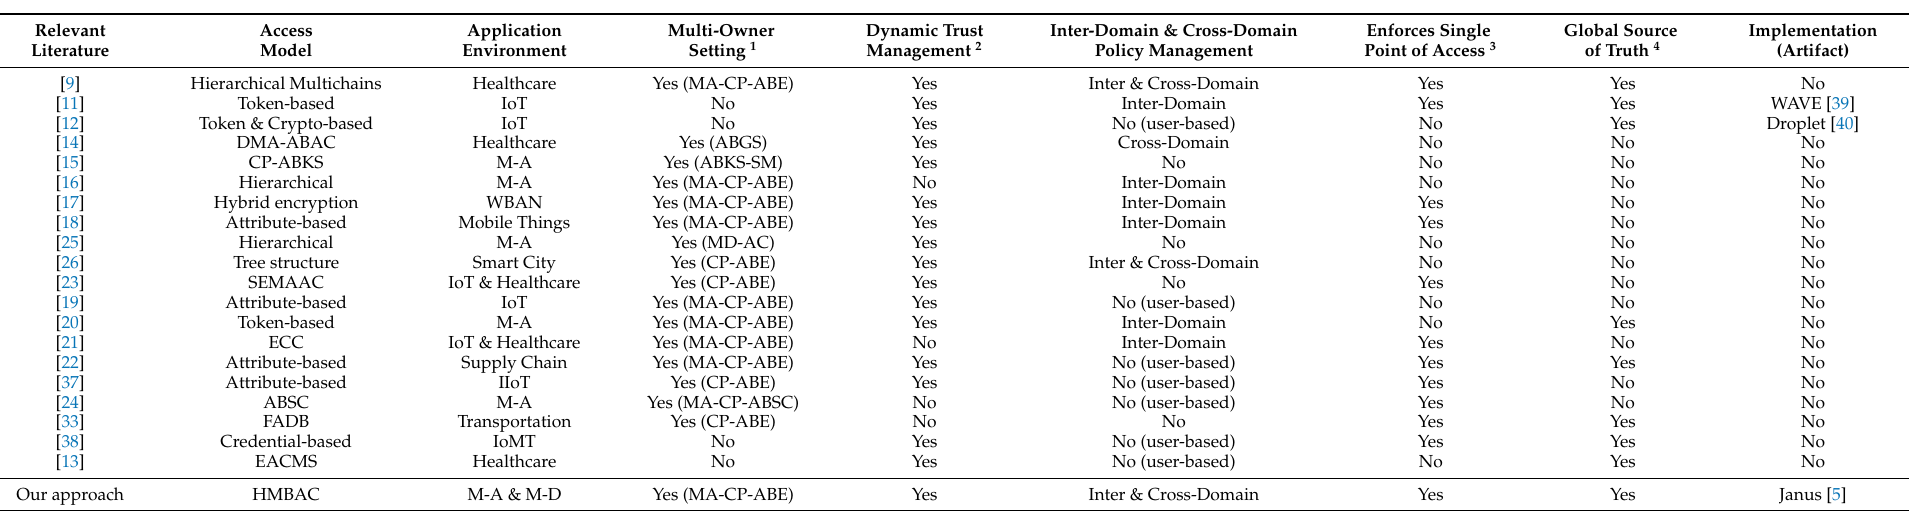
Table 1. Comparative assessment of the various characteristics prevalent in the relevant